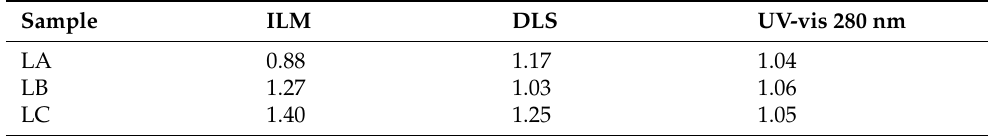
Table 2. Proportions of estimated particle quantity (diluted 1000 × /diluted 100 × ) in liposome samples. Cor-rections due to dilution were taken into account, so ideally, the value 1 would be expected.